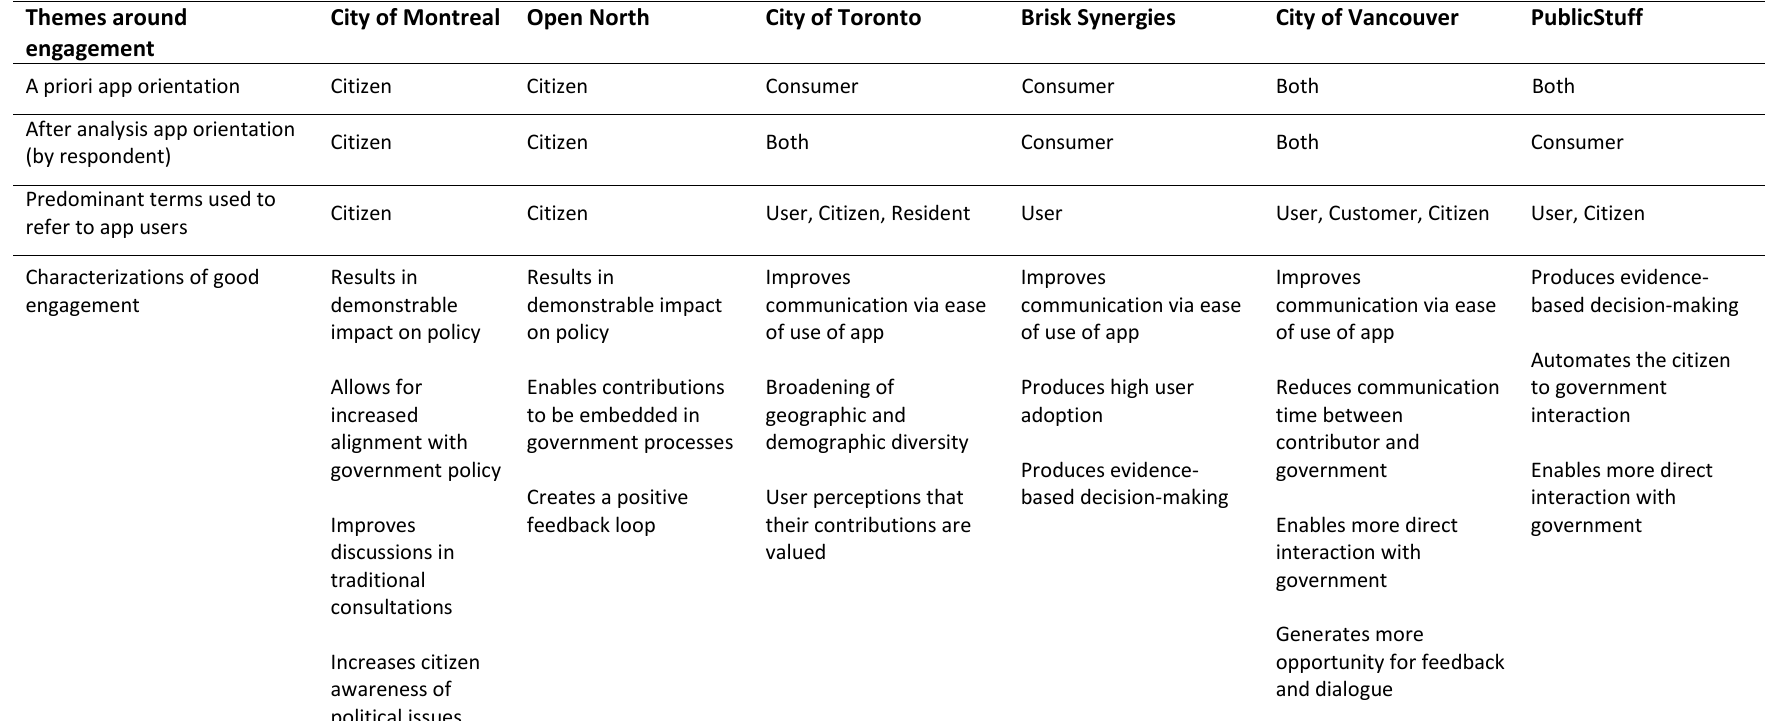
Table 4. Aggregated responses on citizen